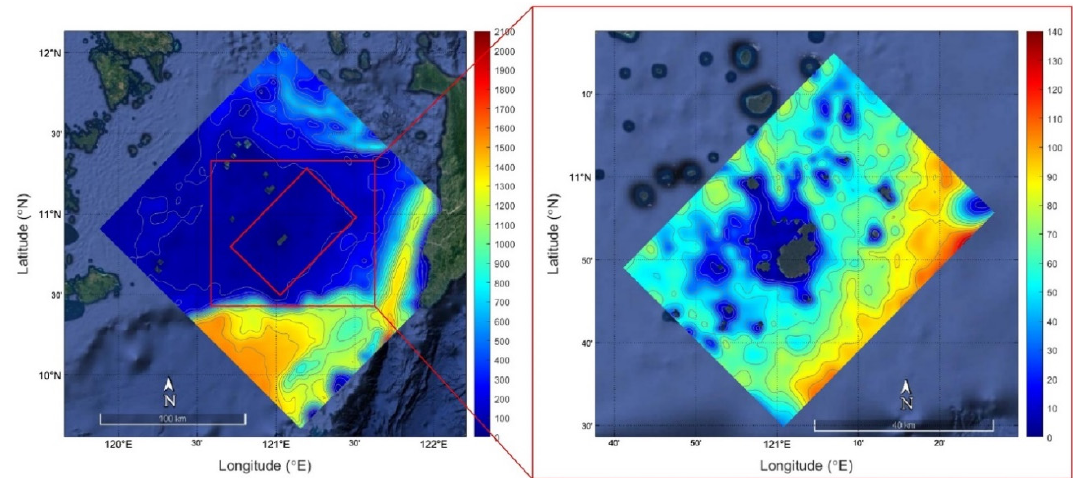
Figure 6. Downloaded GEBCO bathymetric data (adjusted to positive values in meters for Delft3d compatibility) interpolated onto the coarse (left panel) and fine (right panel) grid of the SWAN model. Red is deepest and blue is shallowest. Contour intervals for coarse grid (left panel) are every 100 m depth, while it is every 10 m of depth for fine grid (right panel).